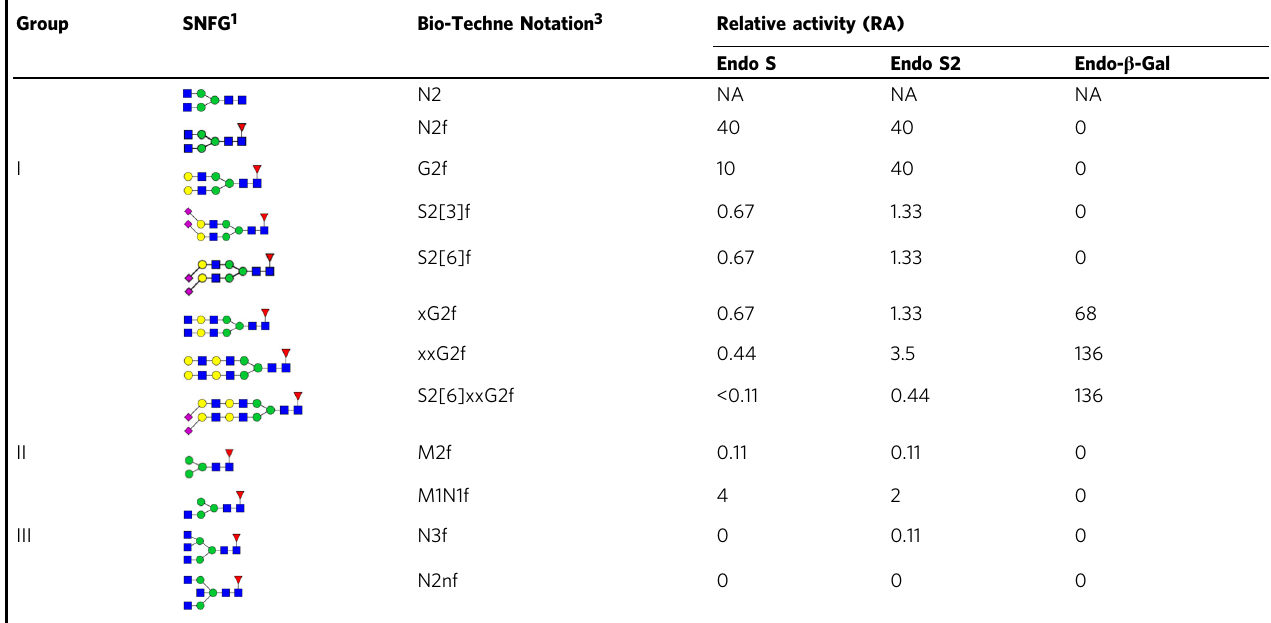
Table 1 Glycan substrates and relative activity for Endo S and Endo S2.